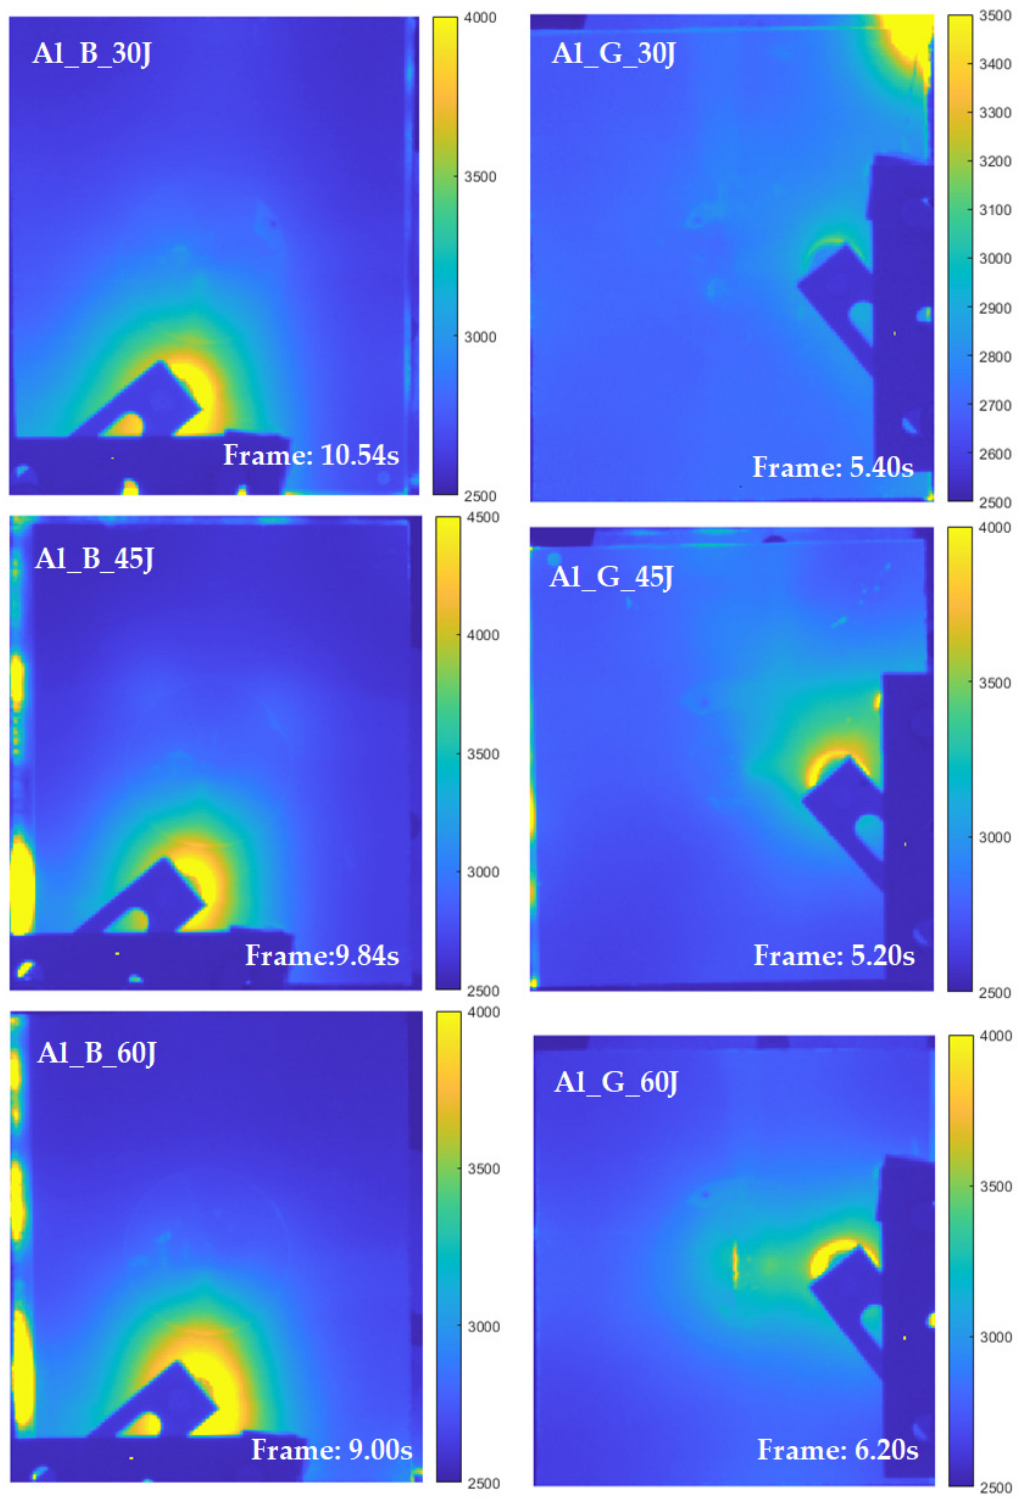
Figure 12. Typical frames from thermal sequences collected from VT experiments on six samples.